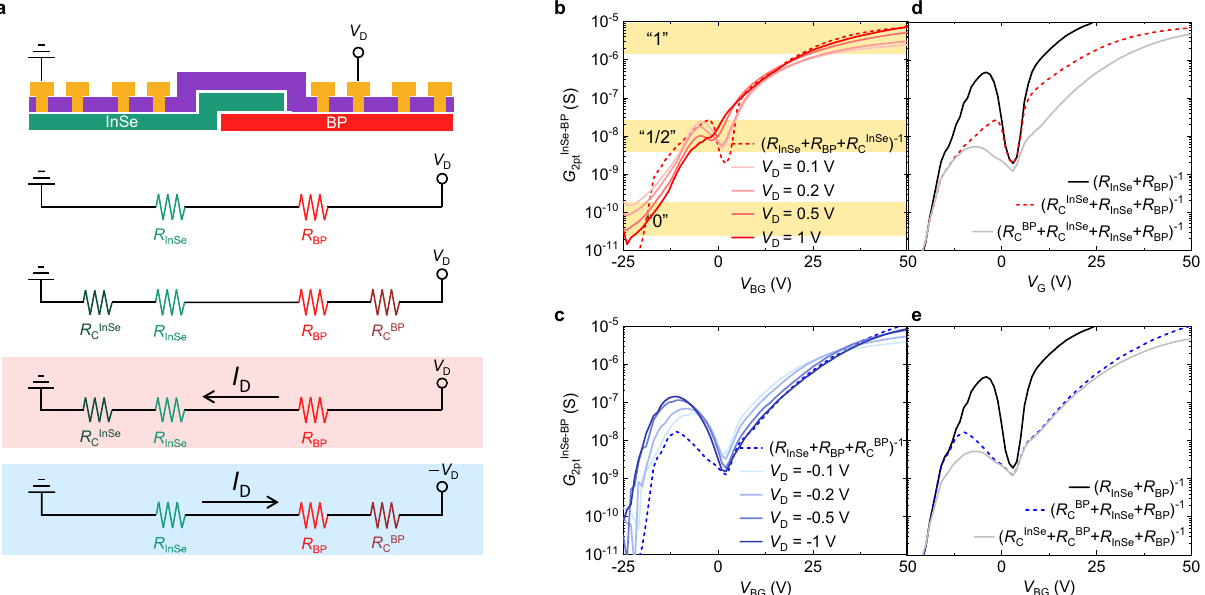
Figure 2. ( a ) Schematics describing the InSe-BP-Ti device (upper) and the four different equivalent circuits, consisting of R InSe , R BP , R C InSe , and R C BP . Depending on current direction, different contact resistance components are more effective. ( b ) G 2pt InSe−BP vs V BG of the InSe-BP-Ti device measured at a forward V D regime, which shows a distinct intermediate logic state with a small fluctuation. The dashed line represents ( R InSe + R BP + R C InSe ) −1 , which is comparable to the measured G 2pt InSe−BP . ( c ) G 2pt InSe−BP vs V BG of the InSe-BP-Ti device measured at a backward V D regime, which shows a strong NDT behavior with PVCR reaching ~ 10 2 at V D = −1 V. The dashed line represents ( R InSe + R BP + R C BP ) −1 , which is comparable to the G 2pt InSe−BP . d,e) ( R InSe + R BP ) −1 , ( R InSe + R BP + R C InSe ) −1 , ( R InSe + R BP + R C BP ) −1 , and ( R InSe + R BP + R C BP + R C InSe ) −1 for comparison with ( b,c ) data, which reveals the thicknesses of the InSe and BP flakes as 15 nm and 4 nm, respectively. Figure 1c shows the three distinct Raman spectra measured on the InSe, BP, and InSe/BP overlap regions (excitation wavelength = 514 nm). 440 cm −1 , and 467 cm −1 from BP are consistent with those previously reported 31,32 , confirming the high quality of our flakes encapsulated by hBN. The Raman spectrum on the overlapped region shows the same peak posi- tions originating from the InSe and BP. The Raman peak intensity is slightly weakened in the InSe/BP overlap region, compared to that in InSe/SiO 2 . This Raman quenching is attributed to the weak but finite van der Waals coupling between the InSe and BP 33,34 . Nearly consistent peak positions and the ratio of A 1 (LO) peak to E 1 2g